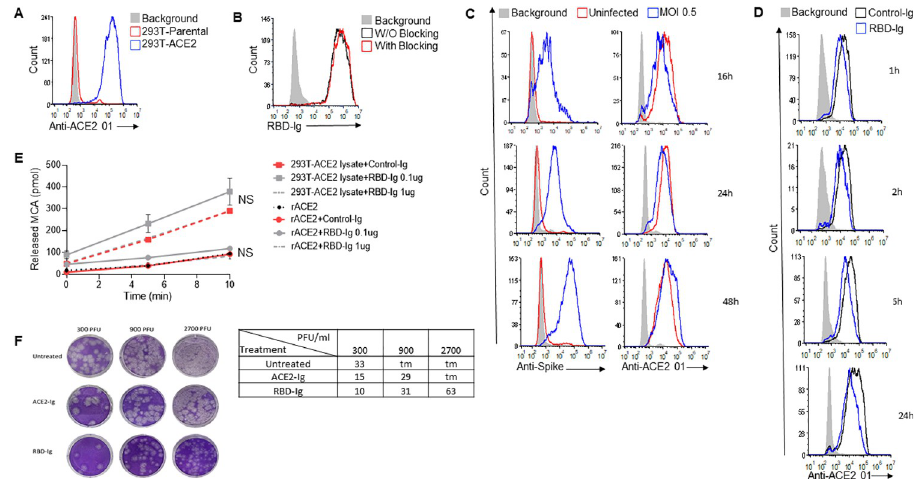
Fig 5. RBD-Ig neutralizes in-vitro infection regardless of SARS-CoV-2 titers. (A) Staining of 293T-Parental cells and 293T-ACE2 cells with the mAb anti-ACE2 01 we generated. (B) Staining of 293T-Parental cells and 293T-ACE2 cells with RBD-Ig. Cells were incubated with or without anti-ACE2 01 for 1 hour at 4˚C, washed and then staining was performed. (C) Staining of infected (MOI 0.5) and uninfected VERO E6 cells with either an anti-Spike antibody to verify infection (left panel) or with our anti-ACE2 01 antibody (right panel) at 16,24,48 hours PI. (D) Staining with anti-ACE 01 of 293T-ACE2 cells which were incubated with 1 μ g of either Control-Ig or RBD-Ig for 1, 2, 6 and 24 hours. (A-D) All histograms were gated on GFP positive cells. (E) ACE2 enzymatic activity assay. Recombinant human ACE2 and 293T-ACE2 cells lysate (10 μ g) were incubated with either Control-Ig (1 μ g) or RBD-Ig (0.1 μ g or 1 μ g), then MCA based peptide substrate was added and plate was immediately read in the fluorescent plate reader. Not significant (NS), Student’s t-test as compared with Control-Ig. (F) Plaque reduction neutralization test. Vero E6 cells were infected with increasing SARS-CoV-2 titers and treated with 0.1 nmol/well of ACE2-Ig or RBD-Ig, picture of the plaques can be seen on the left panel and average number of plaques in the table on the right panel. Too many plaques to count (tm). Figures shows one representative experiment out of three